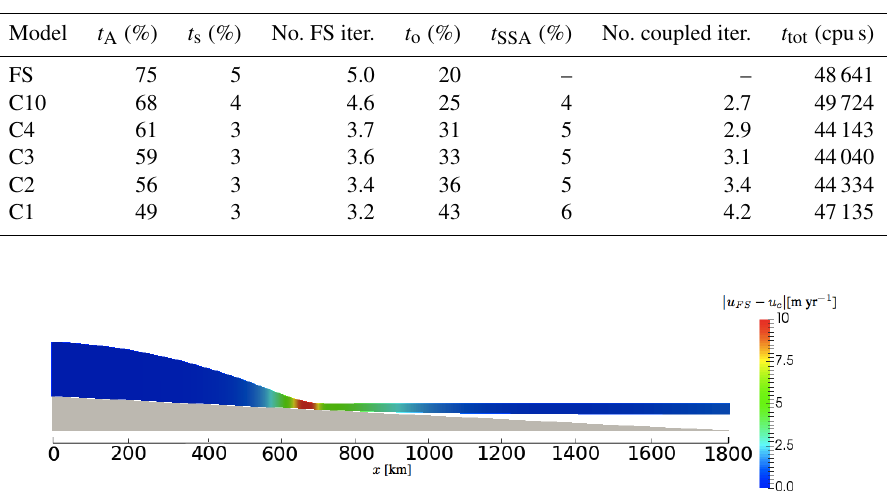
Figure 5. Absolute difference | u FS − u c | (myr − 1 ) after 3000 years. The vertical scale is exaggerated 100 times. The ice thickness ranges from 1445 to 296m.